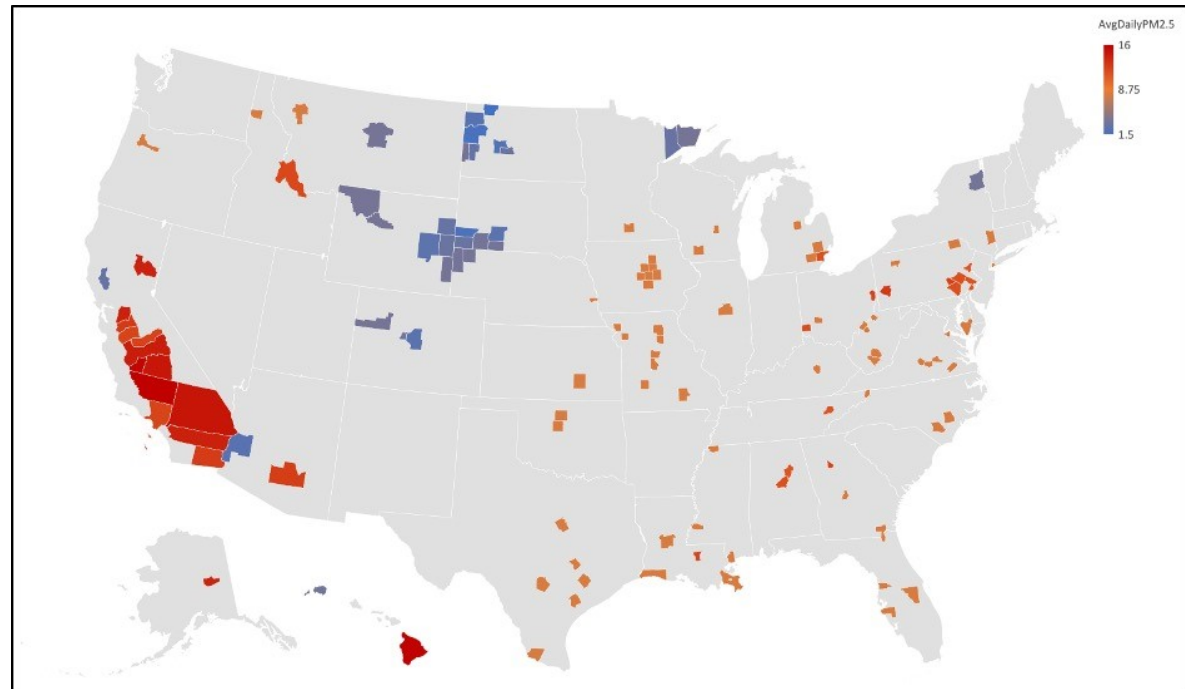
Figure 3. Substudy average daily PM ₂ . ₅ map of U.S. counties. Map of particulate matter concentration levels by county for the stratified substudy. High PM ₂ . ₅ concentrations are concentrated in California’s Central Valley and Hawaii. The middle strata are evenly dispersed across the eastern United States, and low PM ₂ . ₅ levels are concentrated in the Upper Midwest.